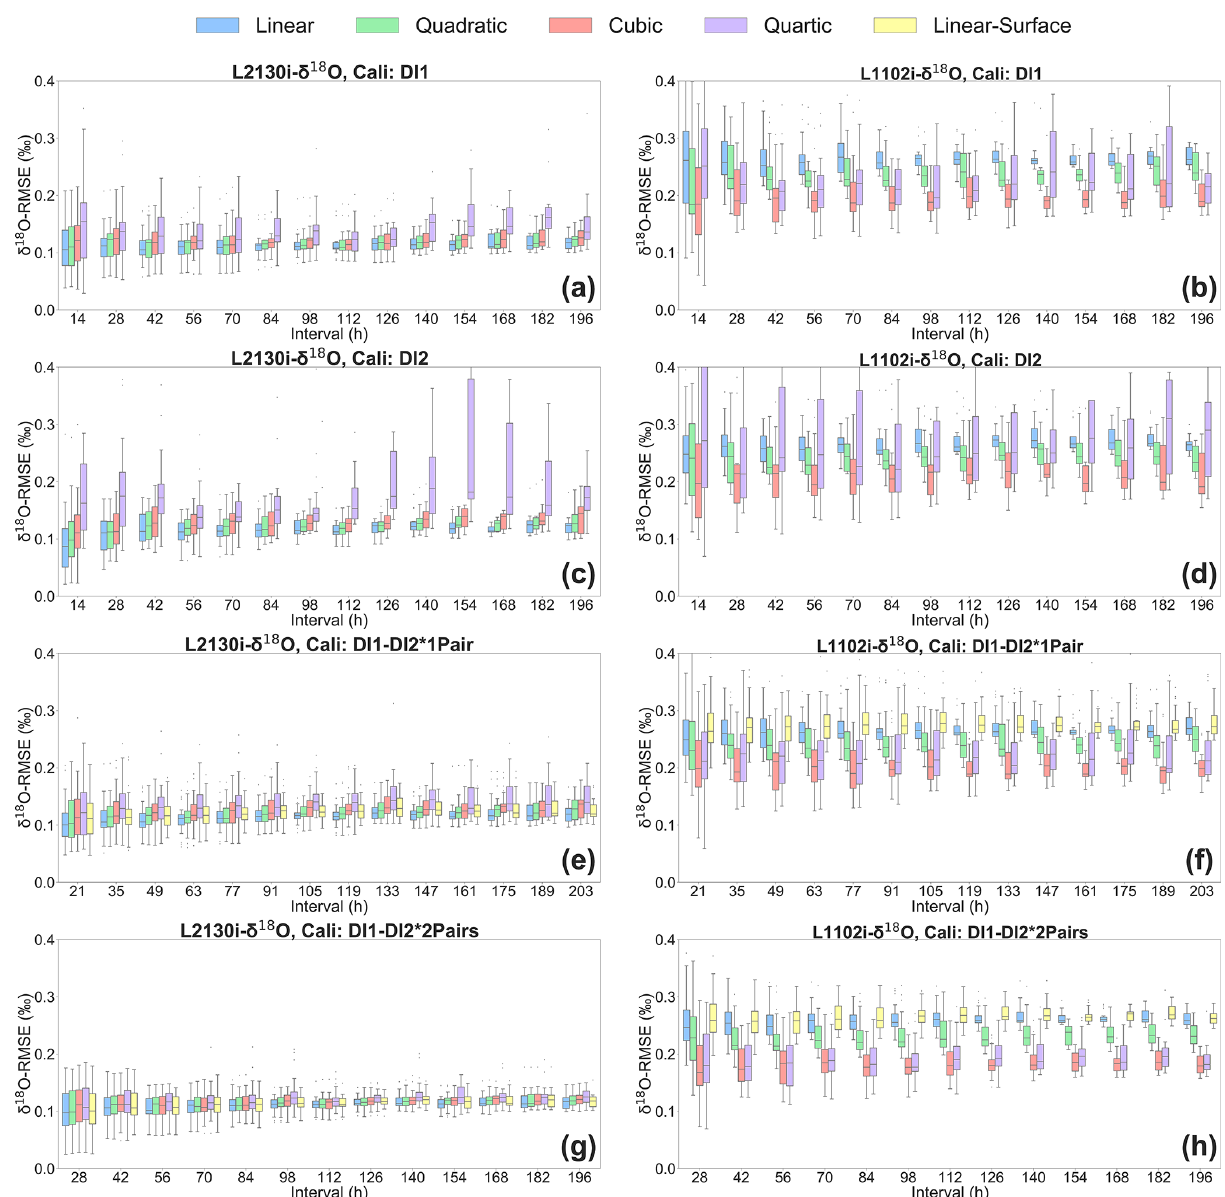
Figure 6. Box plots of root mean square error (RMSE) of δ 18 O, derived from calibrating [H 2 O] dependence of δ 18 O measurements by each of the five fitting methods (i.e. linear, quadratic, cubic, quartic, and linear surface fitting methods) for each of the four calibration strategies: DI1, DI2, DI1–DI2*1Pair, DI1–2*2Pairs. Box plots of (a) L2130’s and (b) L1102’s δ 18 O RMSE for the DI1 strategy, depending on interval length (i.e. the time period used for calibrating [H 2 O] dependence). Box plots of (c) L2130’s and (d) L1102’s δ 18 O RMSE for the DI2 strategy, depending on interval length. Box plots of (e) L2130’s and (f) L1102’s δ 18 O RMSE for the DI1–DI2*1Pair strategy, depending on interval length. Box plots of (g) L2130’s and (h) L1102’s δ 18 O RMSE for the DI1–2*2Pairs strategy, depending on interval length. The procedure for assessing [H 2 O] dependence uncertainties (RMSE) is described in Sect.